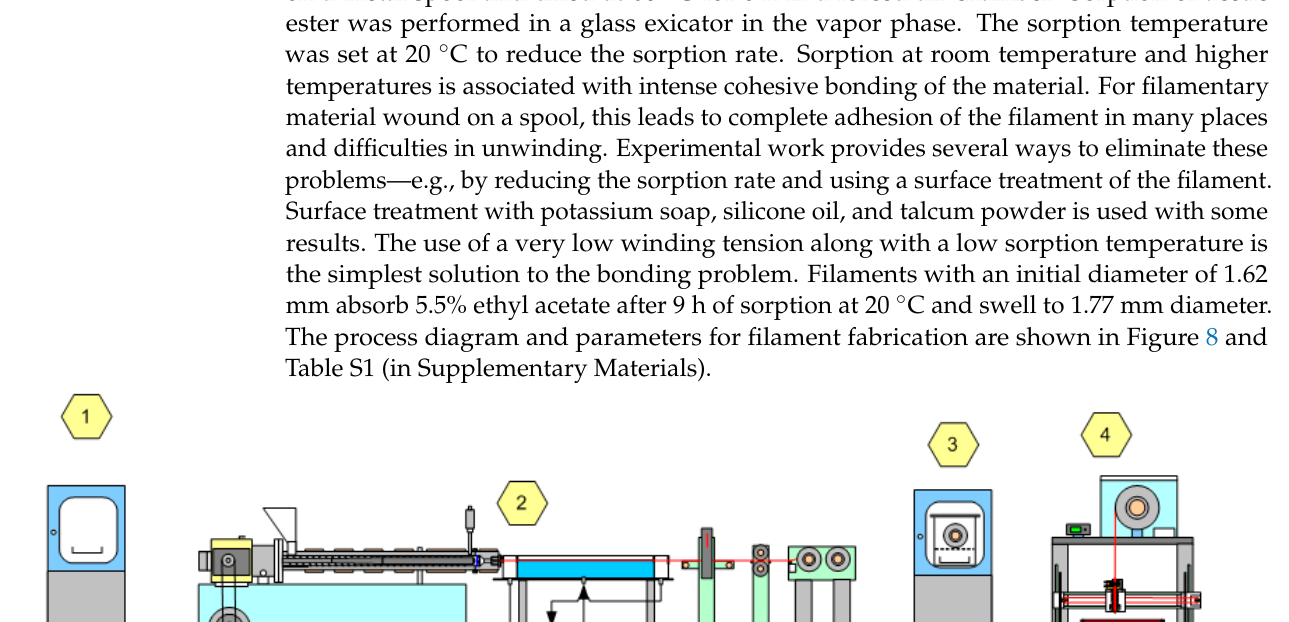
Table 3. AM and slicing process parameters for PETG